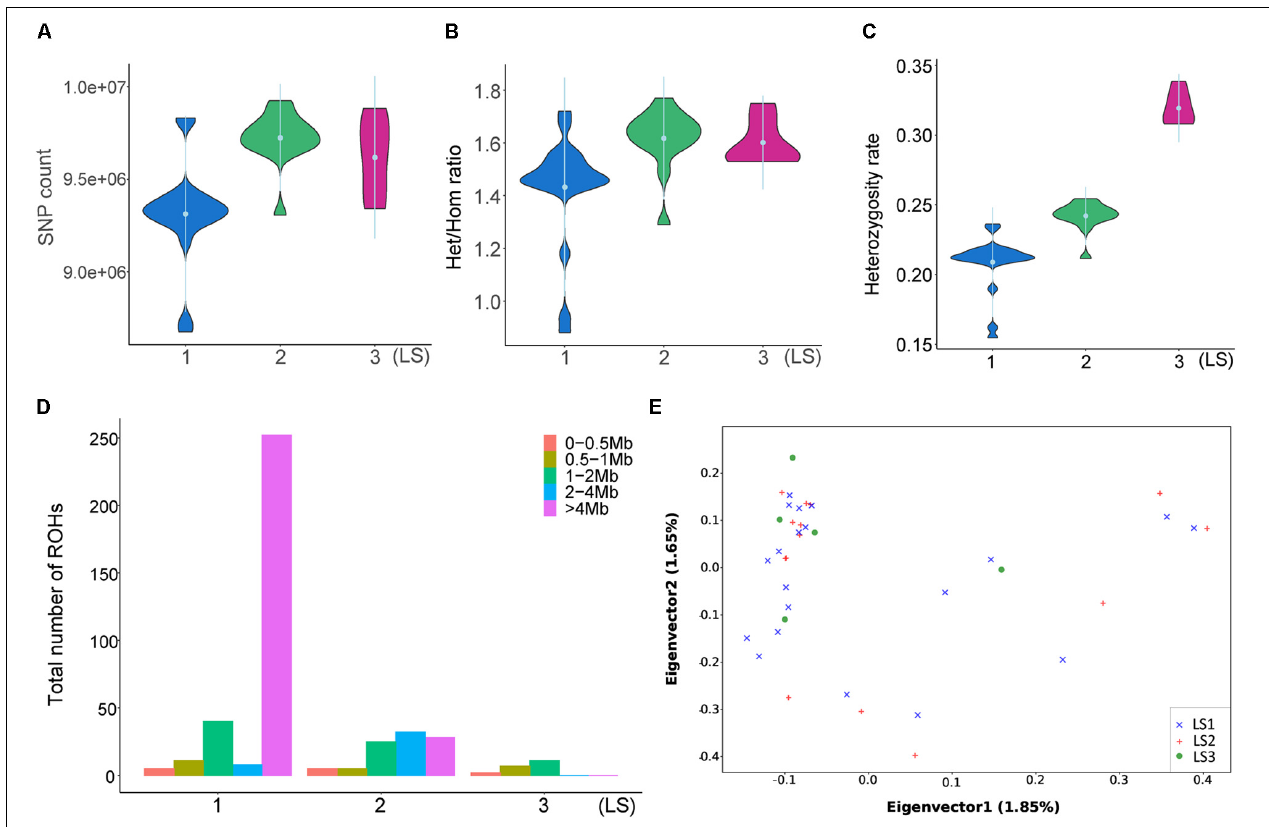
FIGURE 2 | Divergent genetic differentiation of Jining Gray goat groups associated with LS. (A) SNPs number and Het/Hom ratio (B) of LS1, LS2, and LS3 groups. (C) Heterozygosity analysis of LS1, LS2, and LS3 groups. (D) Spectrum of ROH length of diverse LS groups. (E) Principal component analysis (PCA) of LS1, LS2, and LS3